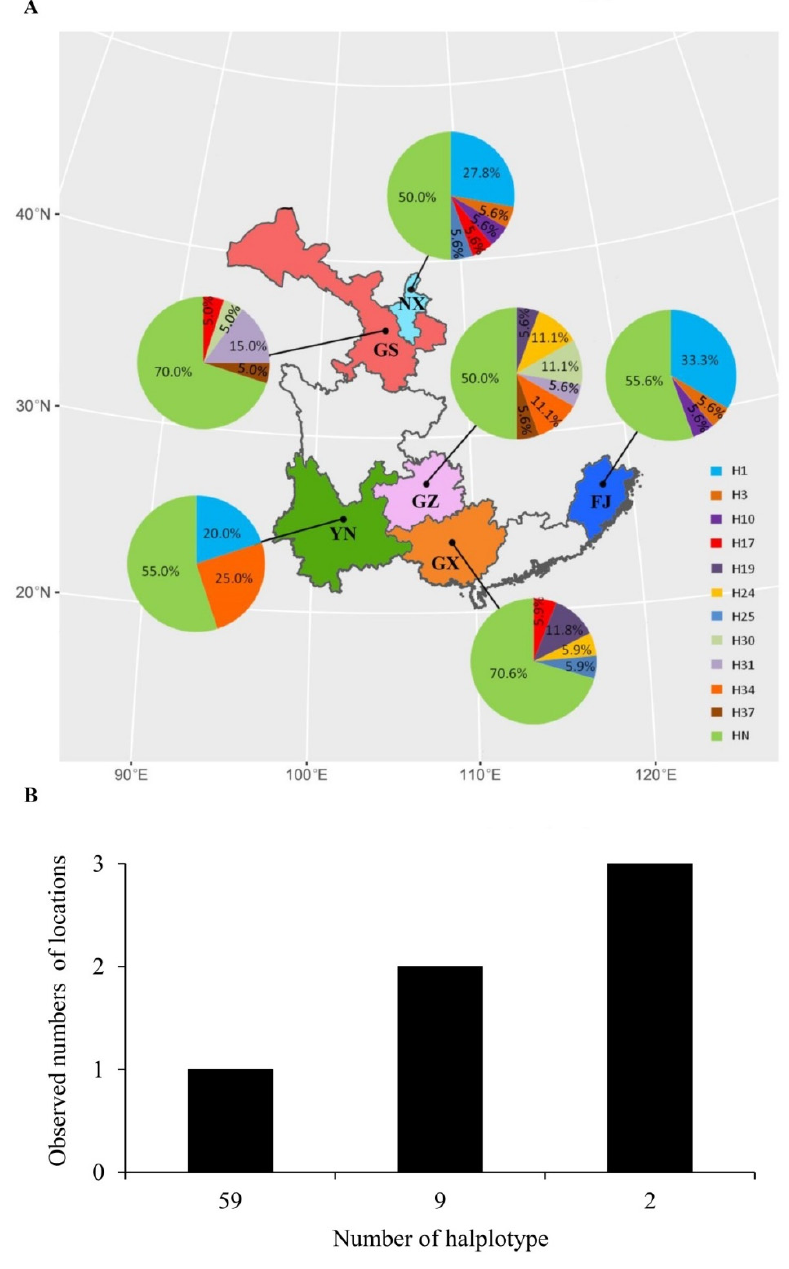
Figure 3. Frequency and spatial distribution of Avr1 nucleotide haplotypes in the Phytophthora infestans populations sampled from six geographic locations of potato fields in China: ( A ) haplotype frequency; ( B ) spatial distribution. Note: HN represents haplotypes detected in only one region.